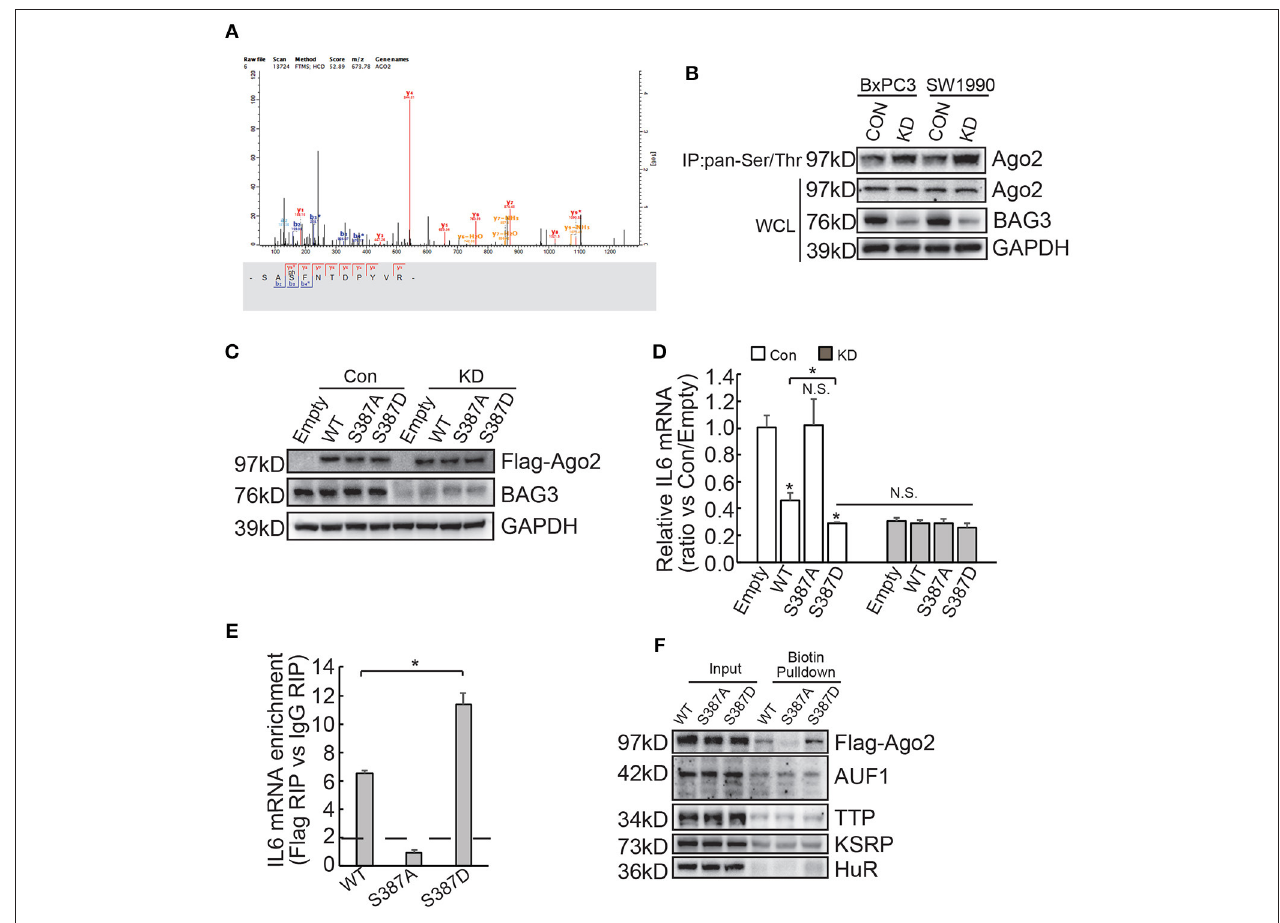
FIGURE 6 | BAG3 knockdown increases Ago2 phosphorylation at Ser387 and facilitates recruitment of Ago2 to IL6 mRNA. (A) Matrix assisted laser desorption ionization time-of-flight peptide mass spectrum showed that phosphorylation of Ago2 at Ser387 was increased in BAG3 knockdown BxPC3 cells. (B) Immunoprecipitation was performed using pan-Ser/Thr antibody, Ago2 phosphorylation was then analyzed using Western blot analysis. (C–E) BxPC3 cells were transfected with wild type (WT), mutation at Ser387 to alanine (S387A) or to aspartic acid (S387D) Ago2, Ago2 expression was confirmed by Western blot (C) , IL6 mRNA was analyzed using real-time RT-PCR (D) , enrichment of IL6 mRNA by Ago2 was performed using RIP with Flag antibody followed by real-time RT-PCR (E) . (F) Biotinylated 3 ′ UTR RNA segment of IL6 mRNA was used to pulldown lysates from BxPC3 cells transfected with WT, S387A or S387D Ago2 construct, and the pulldown materials were analyzed by western blotting analysis using the indicated antibodies. N.S., not significant; * P < 0.01.